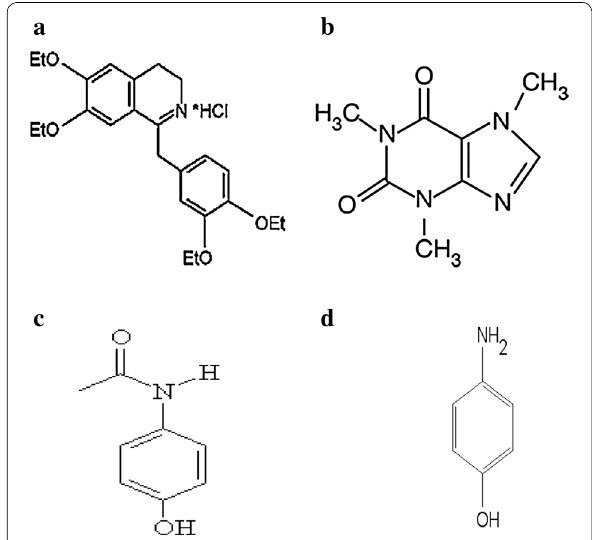
Fig. 1 Structural formulae for a drotaverine, b caffeine, c paraceta- mol, d